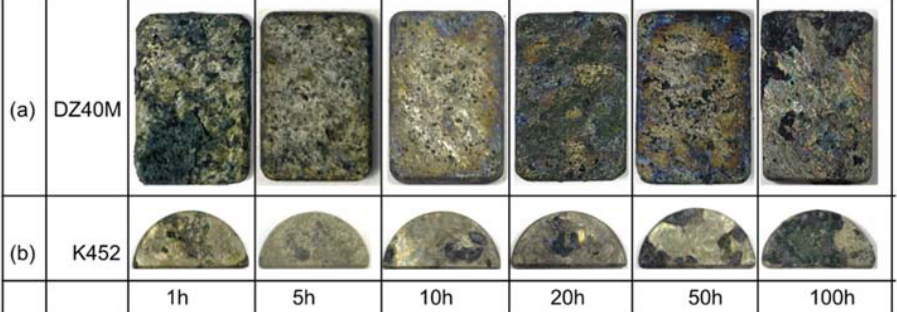
Figure 4. Macro ‐ morphology of continuous hot corrosion of DZ40M and K452. ( a ) DZ40M, (b) K452.